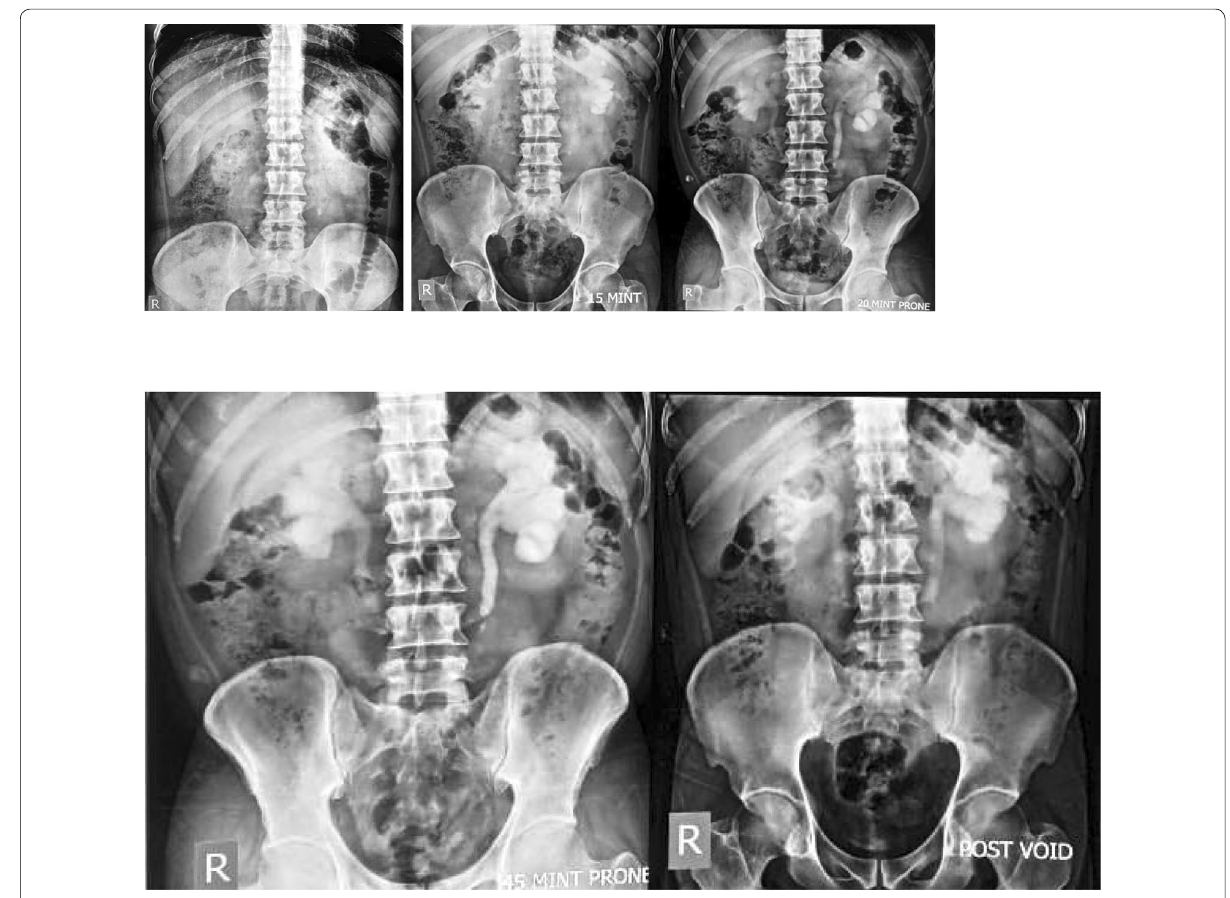
Fig. 3 Left ureteric stone detected by X-ray KUB and IVU in non-pregnant patient